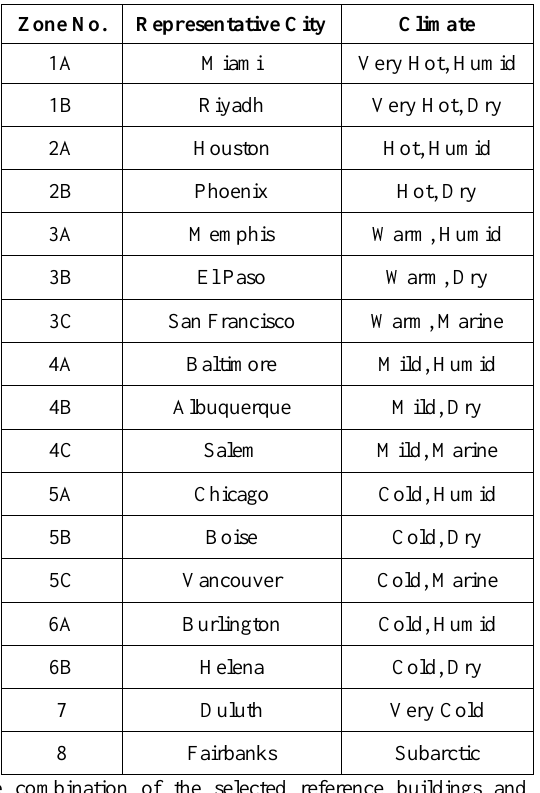
Table 2. Representative cities and climates.